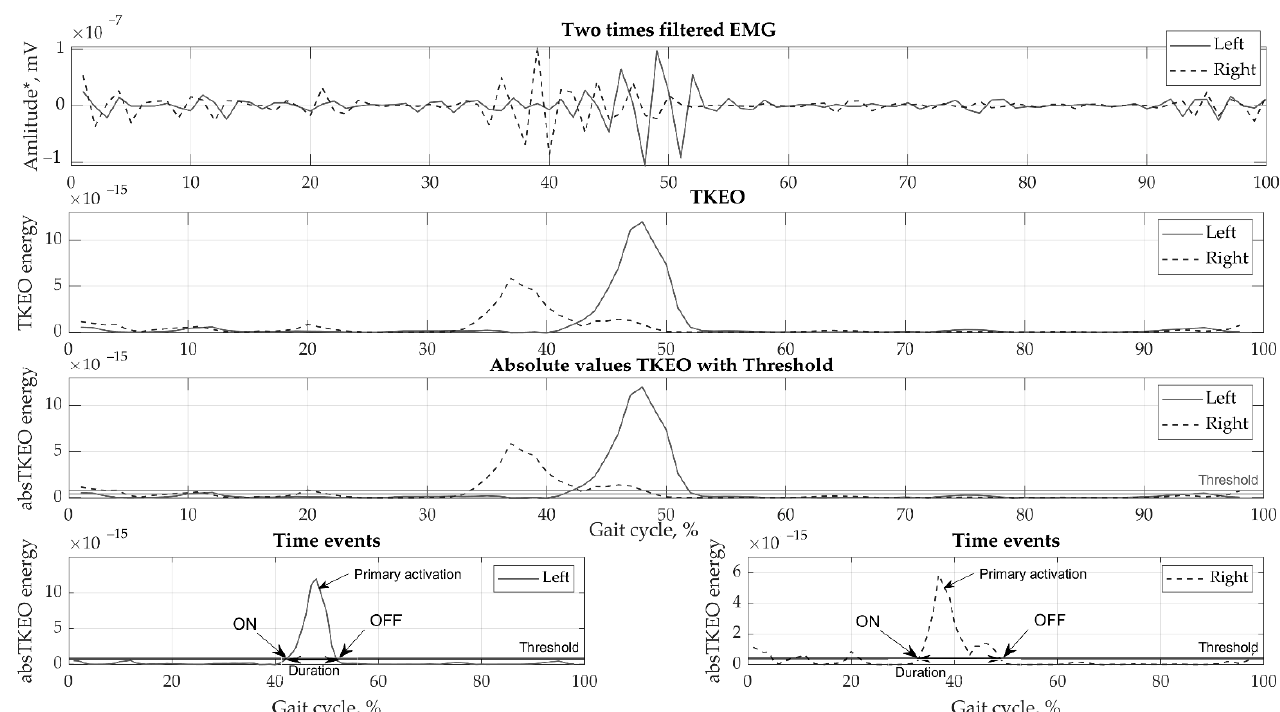
Figure 2. Example of EMG processing steps showing a single biceps femoris sample.